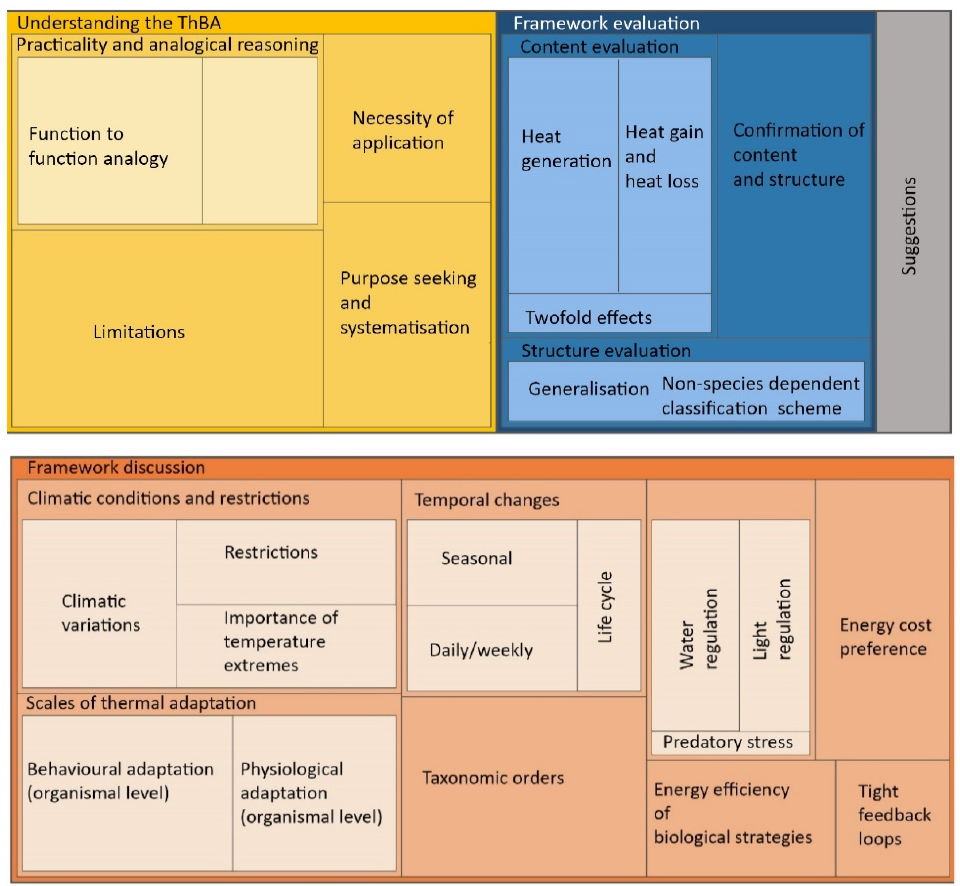
Figure 4. Proportional representation of all references coded for the main themes.